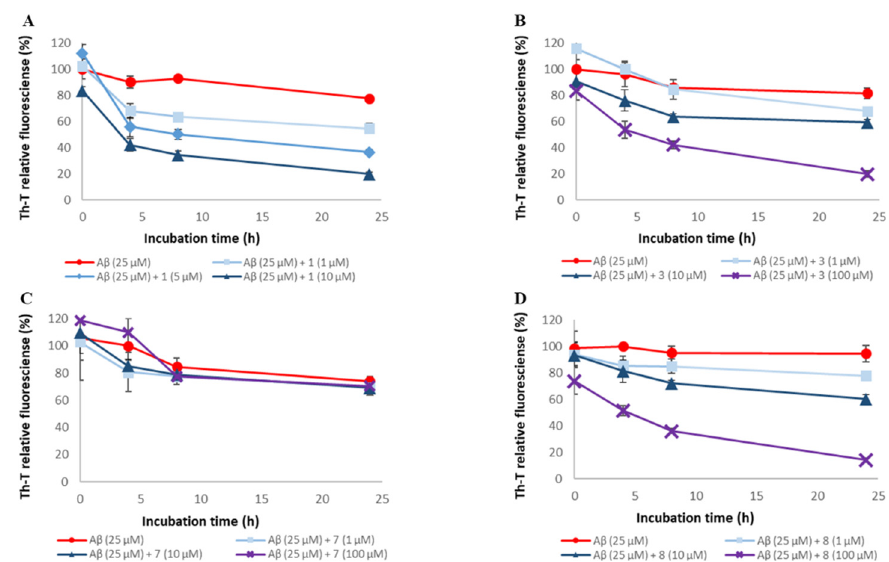
Table 2. Efficacy of compounds 1 , 3 , 5 , 7 , and 8 against pre-existing A β 42 and hIAPP aggregates.